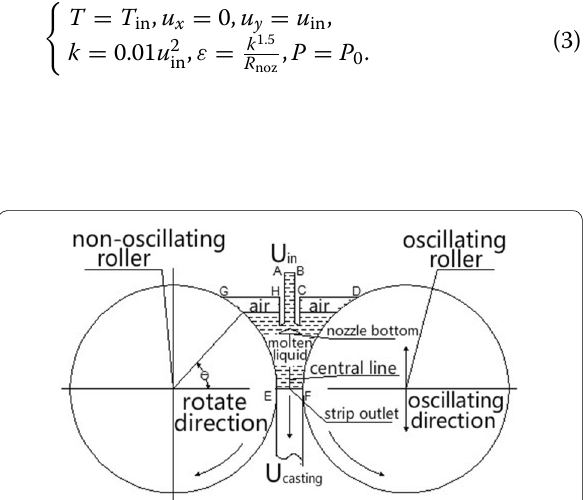
Figure 1 Schematic of the oscillating twin‑roll strip casting